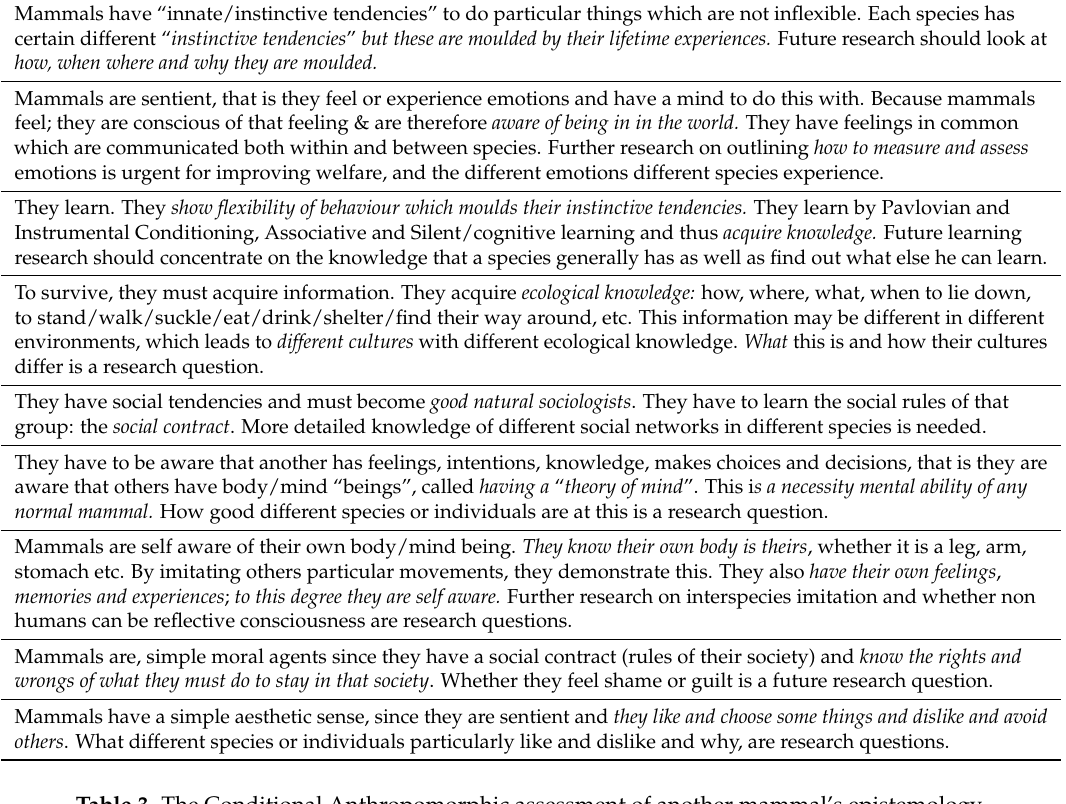
Table 2. Mammalian Mental Homologies. The baseline mental skills that define mammals.